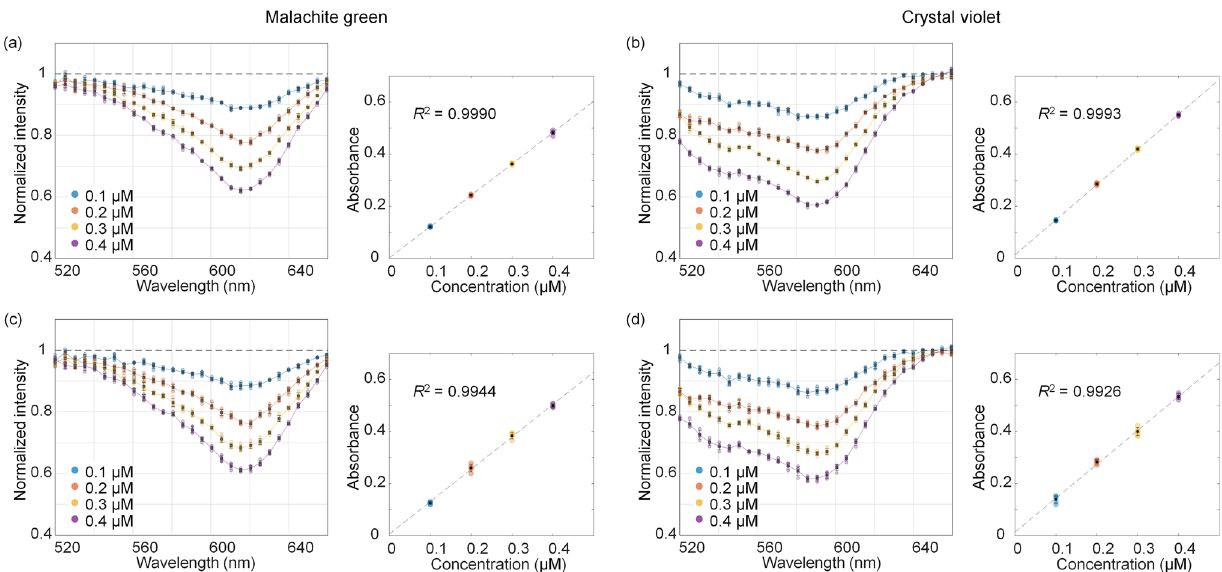
Figure 3. Normalized spectra and absorbance at the dip wavelength at the concentrations of 0.1, 0.2, 0.3, and 0.4 µM for ( a , c ) malachite green and ( b , d ) crystal violet aqueous solutions. The absorbance at the dip wavelength as a function of concentrations is represented together. ( a , b ) are the results of measuring five times for the same solution; ( c , d ) are the results of producing five solutions and measuring for each solution. The black dots represent the average of the results conducted five times. Error bars, standard